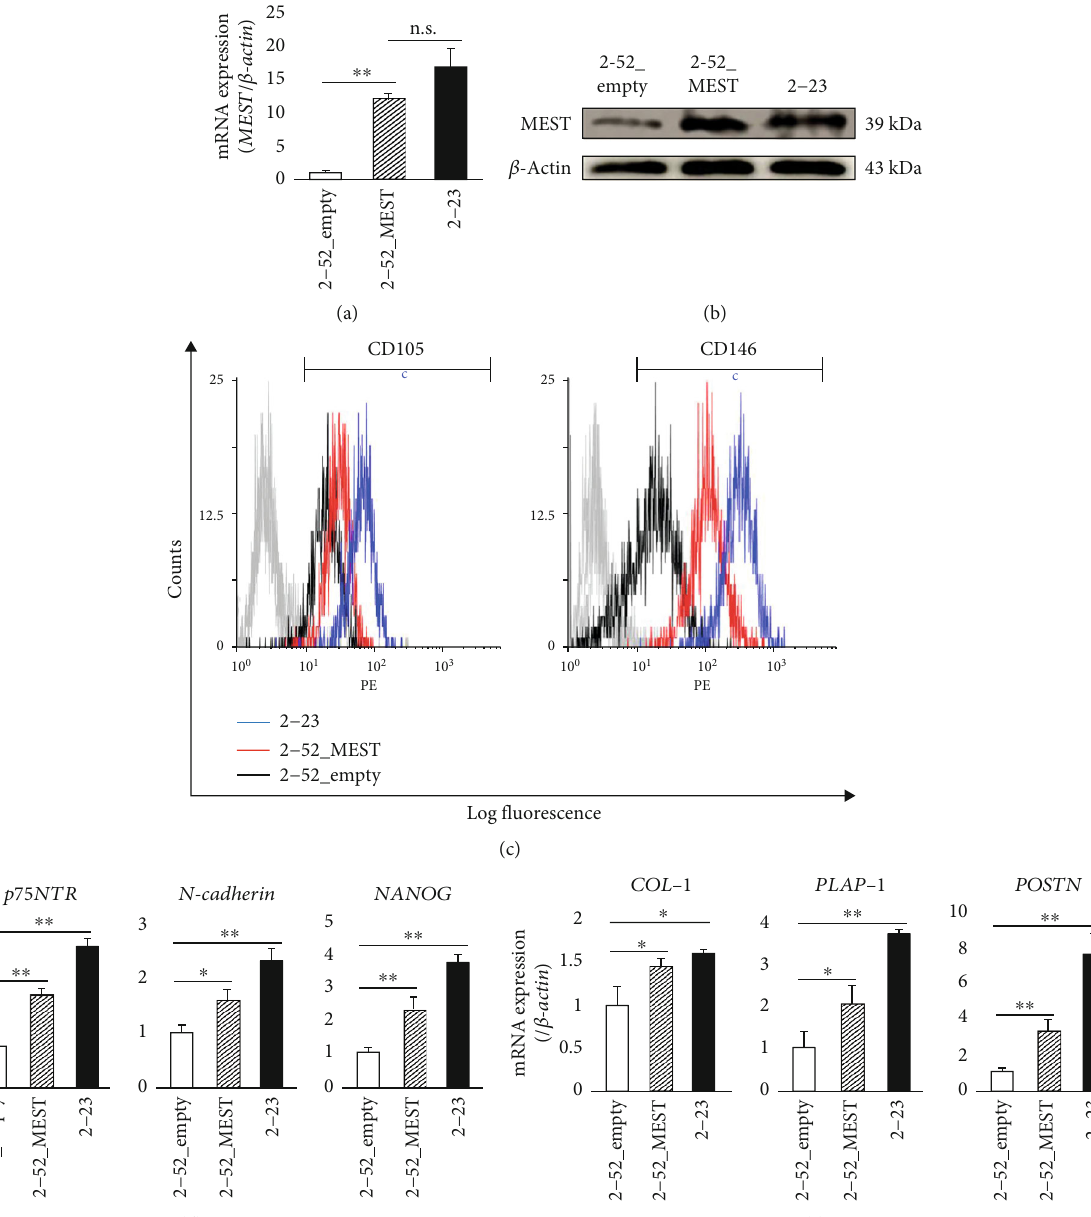
Figure 5: The e ff ects of MEST overexpression on the expression of stem cell markers and PDL-related markers in 2-52 cells. (a, b) The expression of MEST mRNA (a) and protein (b) in 2-52 cells transfected with empty vector (2-52_empty), 2-52 cells transfected with vector coding human MEST (2-52_MEST), and 2-23 cells was assessed by quantitative RT-PCR and western blot analyses, respectively. (c) The expression intensities of CD105 and CD146 in 2-52_empty (black line), 2-52_MEST (red line), and 2-23 cells (blue line) were demonstrated by fl ow cytometric analysis. In the gated region, positive cells. (d) The gene expression of p75NTR , N-cadherin , and NANOG in 2-52_empty, 2-52_MEST, and 2-23 cells was assessed by quantitative RT-PCR. (e) The gene expression of COL-1 , PLAP-1 , and POSTN in 2-52_empty, 2-52_MEST, and 2-23 cells was assessed by quantitative RT-PCR. (a, d, e) In quantitative RT-PCR, the expression levels of these genes were normalized against β -actin expression. All values are means ± S : D : (error bars) of quadruplicate assays. ∗∗ p < 0 : 01 , ∗ p < 0 : 05 ; n.s.: not signi fi